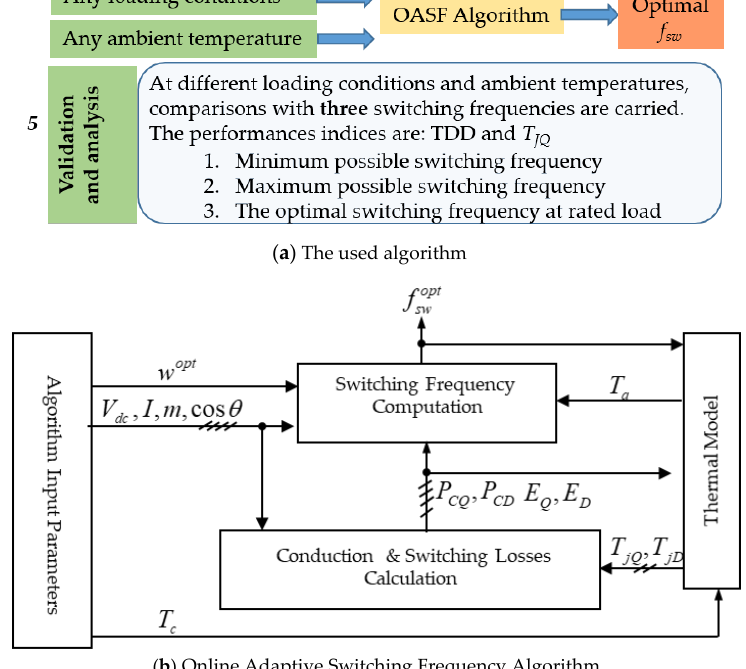
Figure 3. Summary of the proposed work ( a ) the used algorithm; ( b ) OASF implementation in the FPGA.